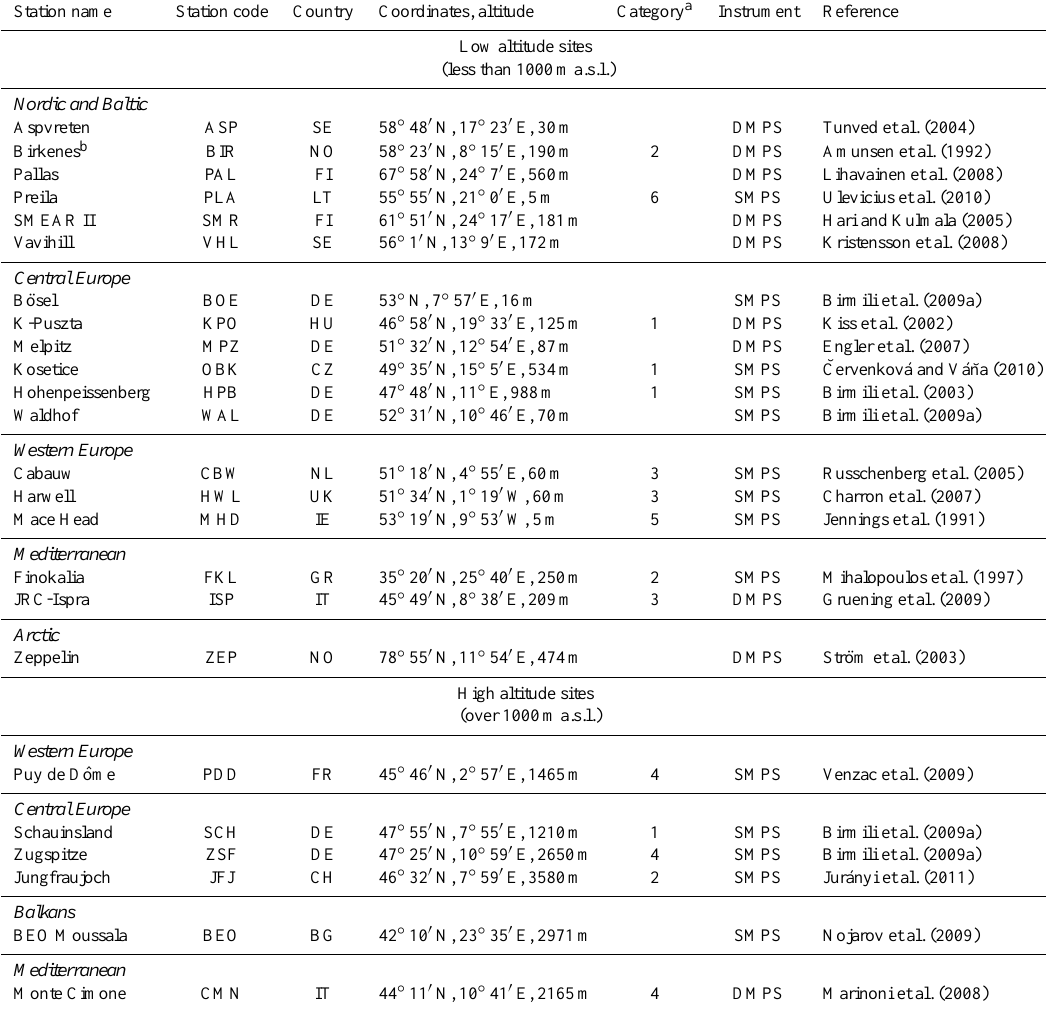
Table 2. Locations and names of stations used in the data analysis. The site altitudes are given in reference to standard sea level. The areas indicated are grouped by European sub-divisions using definitions from Central Intelligence Agency (2009). Country codes are given in ISO 3166